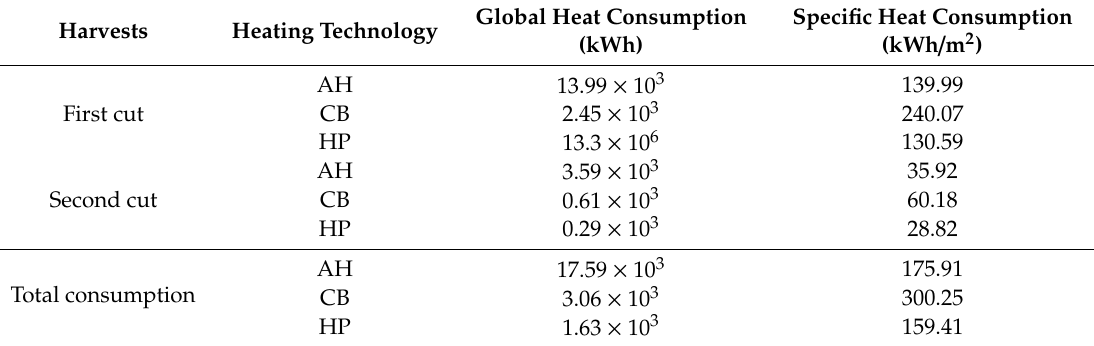
Table 7. Global and specific heat consumption for the studied heating technologies. CB: condensing boiler; AH: air heater; HP: heat pump.